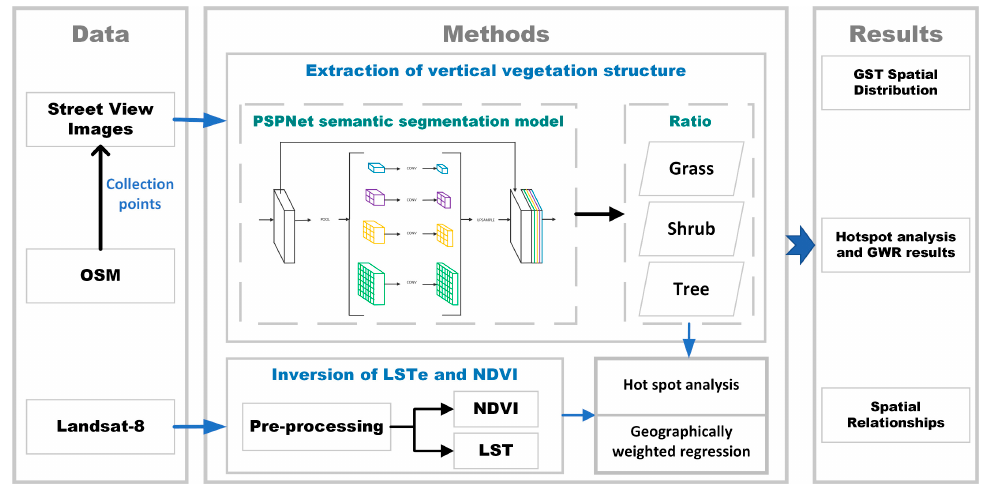
Figure 1. A sketch map of the research methodology.